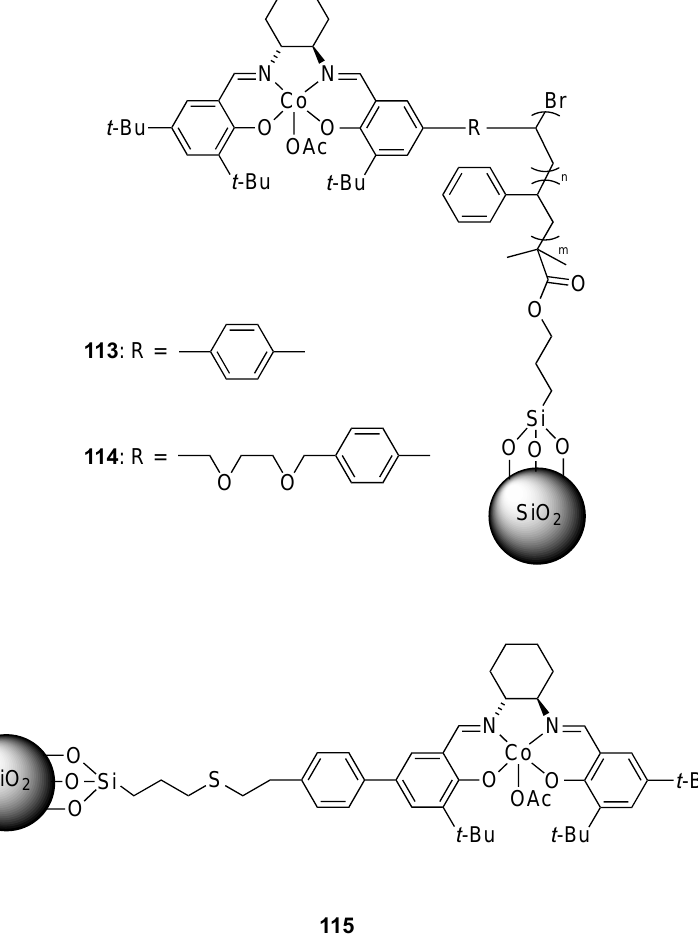
Figure 45. Silica-immobilized copolymeric Co–salen complexes ( 113 and 114 ) and silica-immobilized monomeric complex ( 115 ).